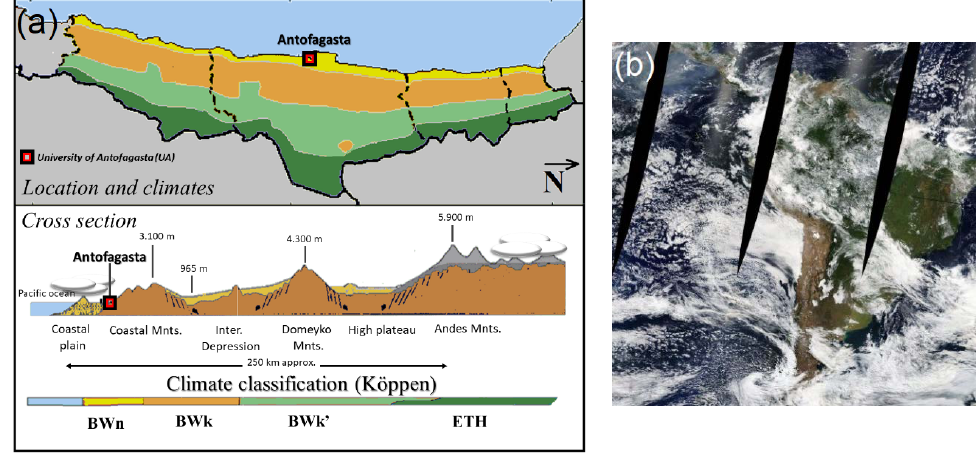
Figure 2. ( a ) University of Antofagasta (UA) campus, cross-section of the Antofagasta Region and climate classification, according to Köppen. Image based on [22]. ( b ) Picture taken by Terra satellite on 28 April 2019 [23], showing a portion of Atacama Desert.